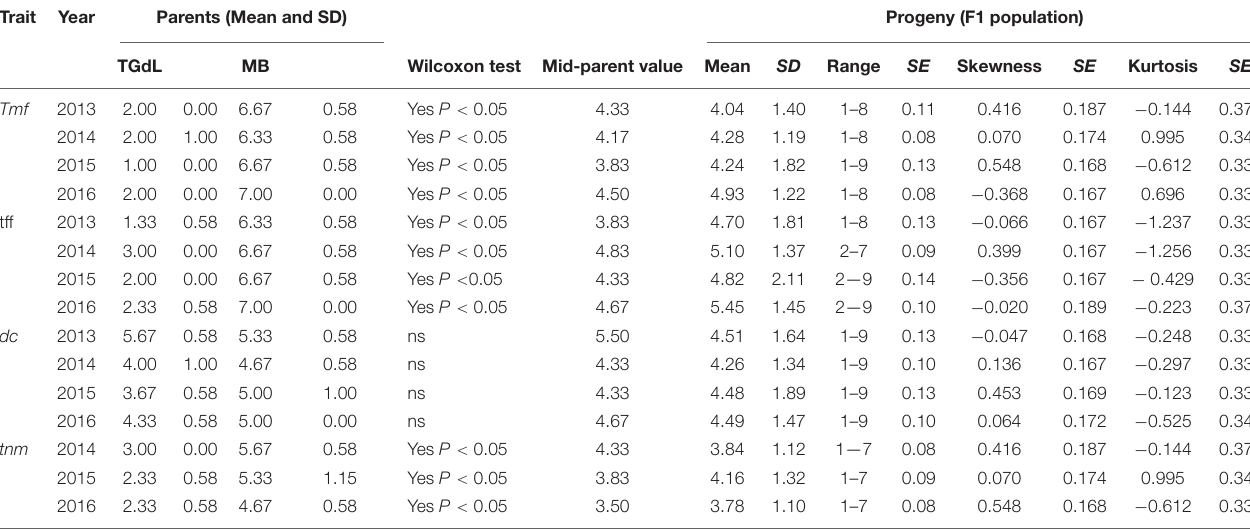
Variation between the mapping population parents presented in the form of means and standard deviations (SD) (n = 3) and the mid-parent value. The significance of differences between means was inferred using the Wilcoxon test. Variation across the mapping population presented as mean, SD, range, standard error (SE), and normality (skewness and kurtosis) (n = 213). Time of male flowering (tmf), time of female flowering (tff), and time of nut maturity (tnm) were rated from 1 = very early to 9 = very late. Dichogamy (dc) was rated from 1 = very protandrous to 9 = very